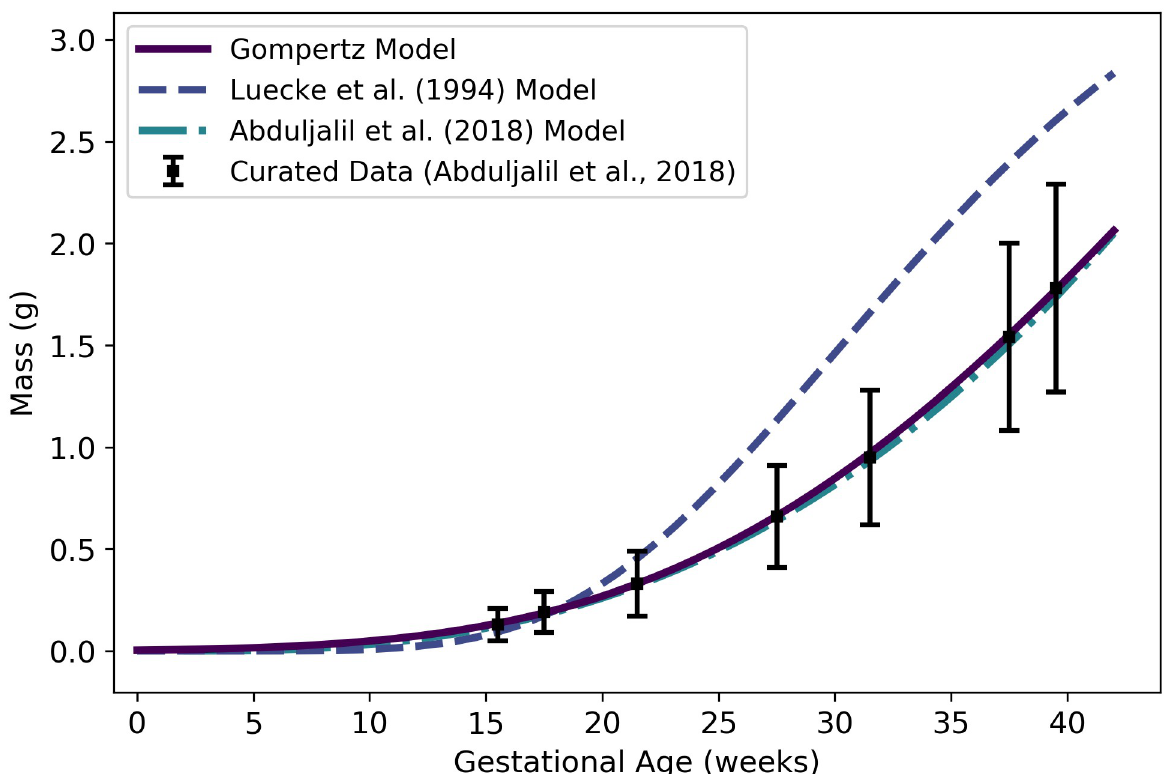
Fig 19. Fetal thyroid mass vs. gestational age. The Gompertz model (solid line) given by Eq 39 was selected as the most parsimonious model in our analysis. The model of Luecke et al. [15], which is a power law model based on fetal mass, was calibrated using a different data set [25].